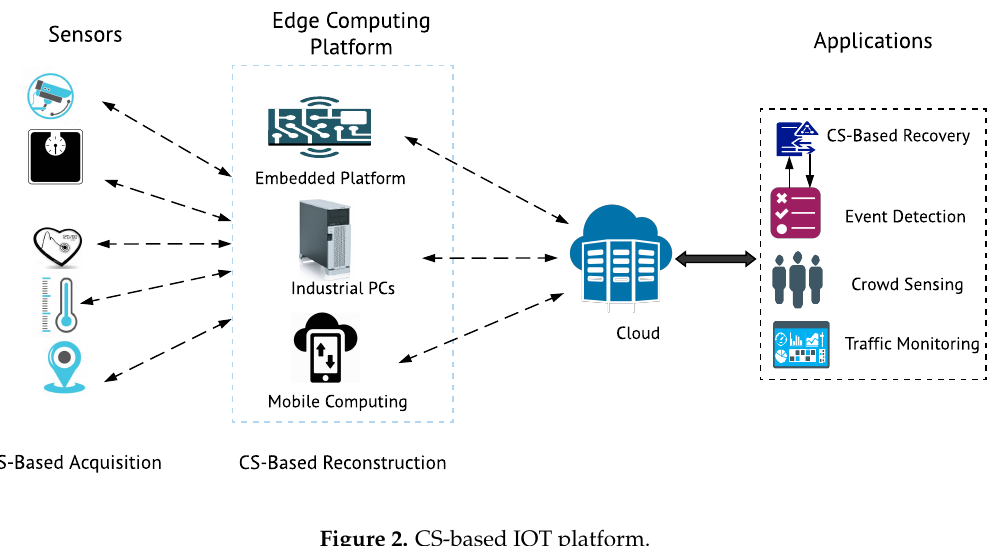
Figure 2. CS-based IOT